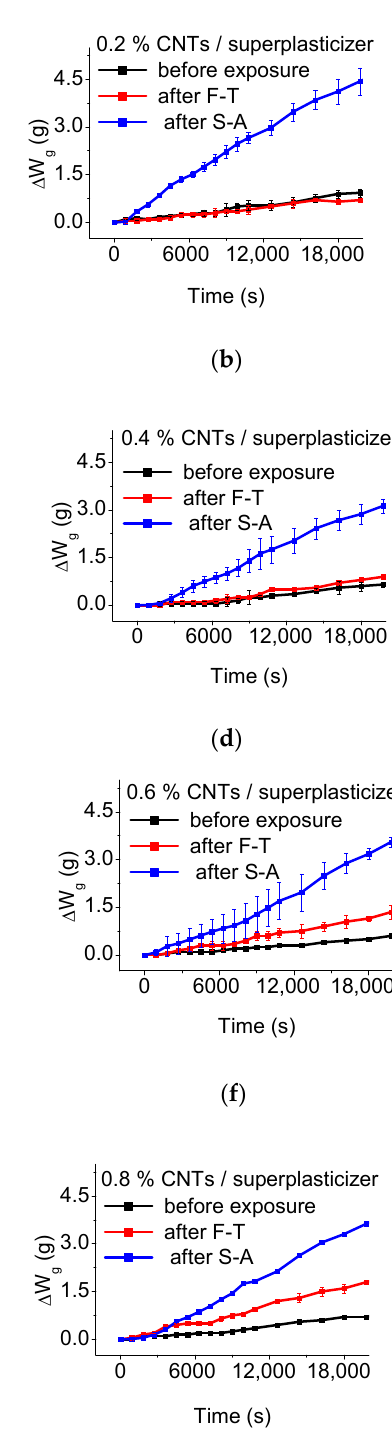
Figure 9. Effect of exposure state on the ( a ) water absorption, and ( b ) gas permeability profiles of un- modified mortars .